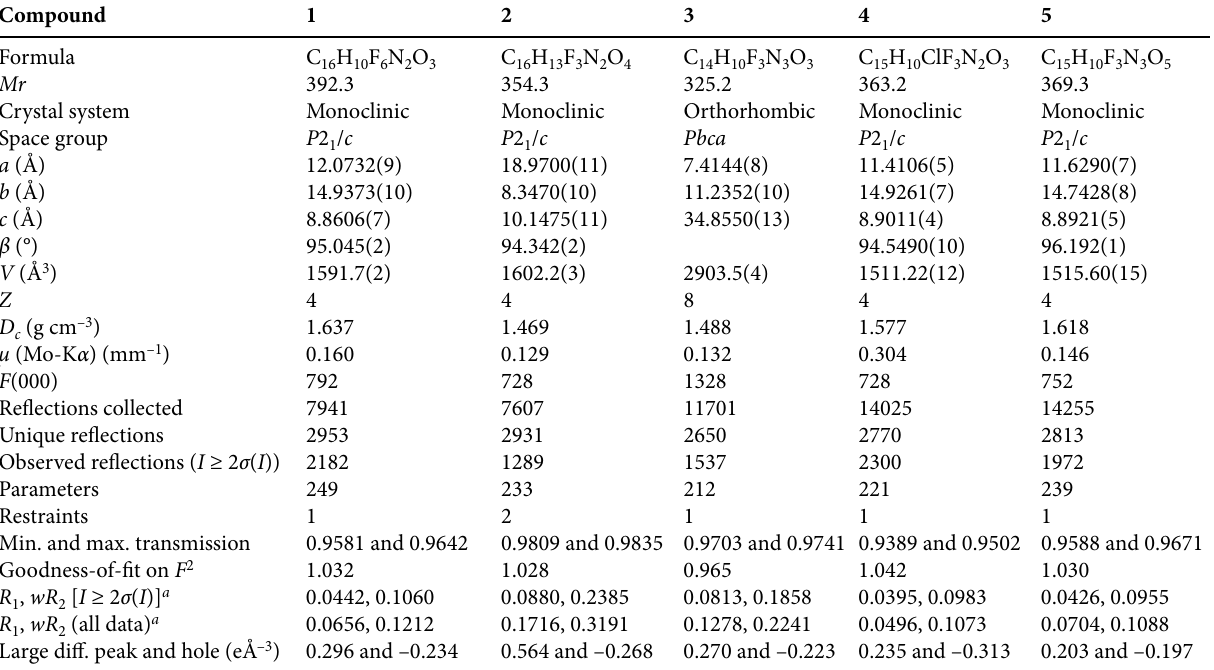
Table 1. Crystallographic and experimental data for the compounds 1 – 5